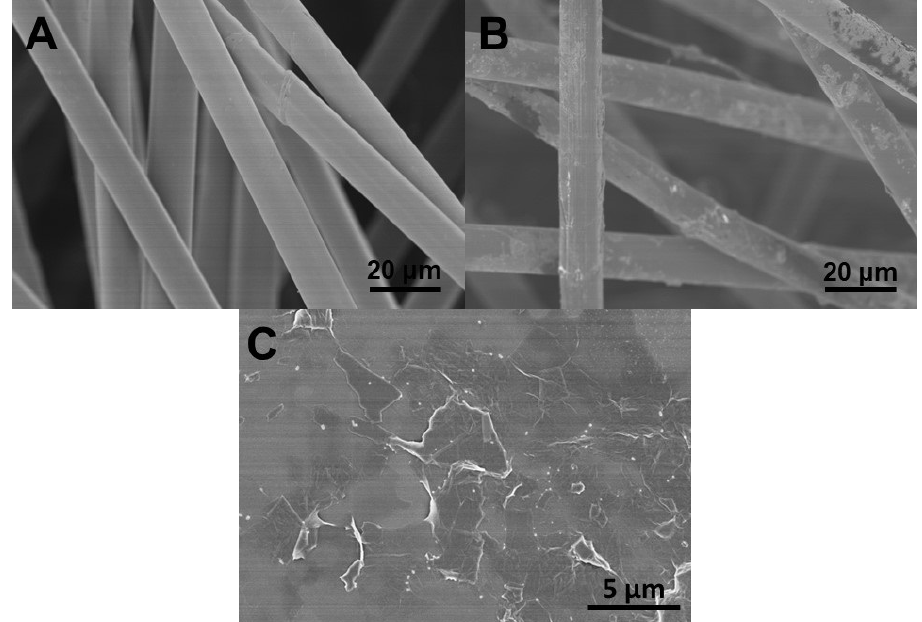
Figure 8: SEM images of (A) pure chopped AFs; (B) GO-AFs; (C) GO